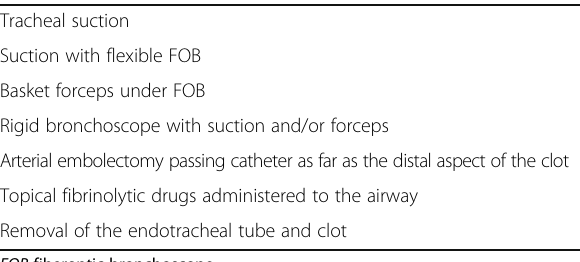
Table 1 Various previously described methods of